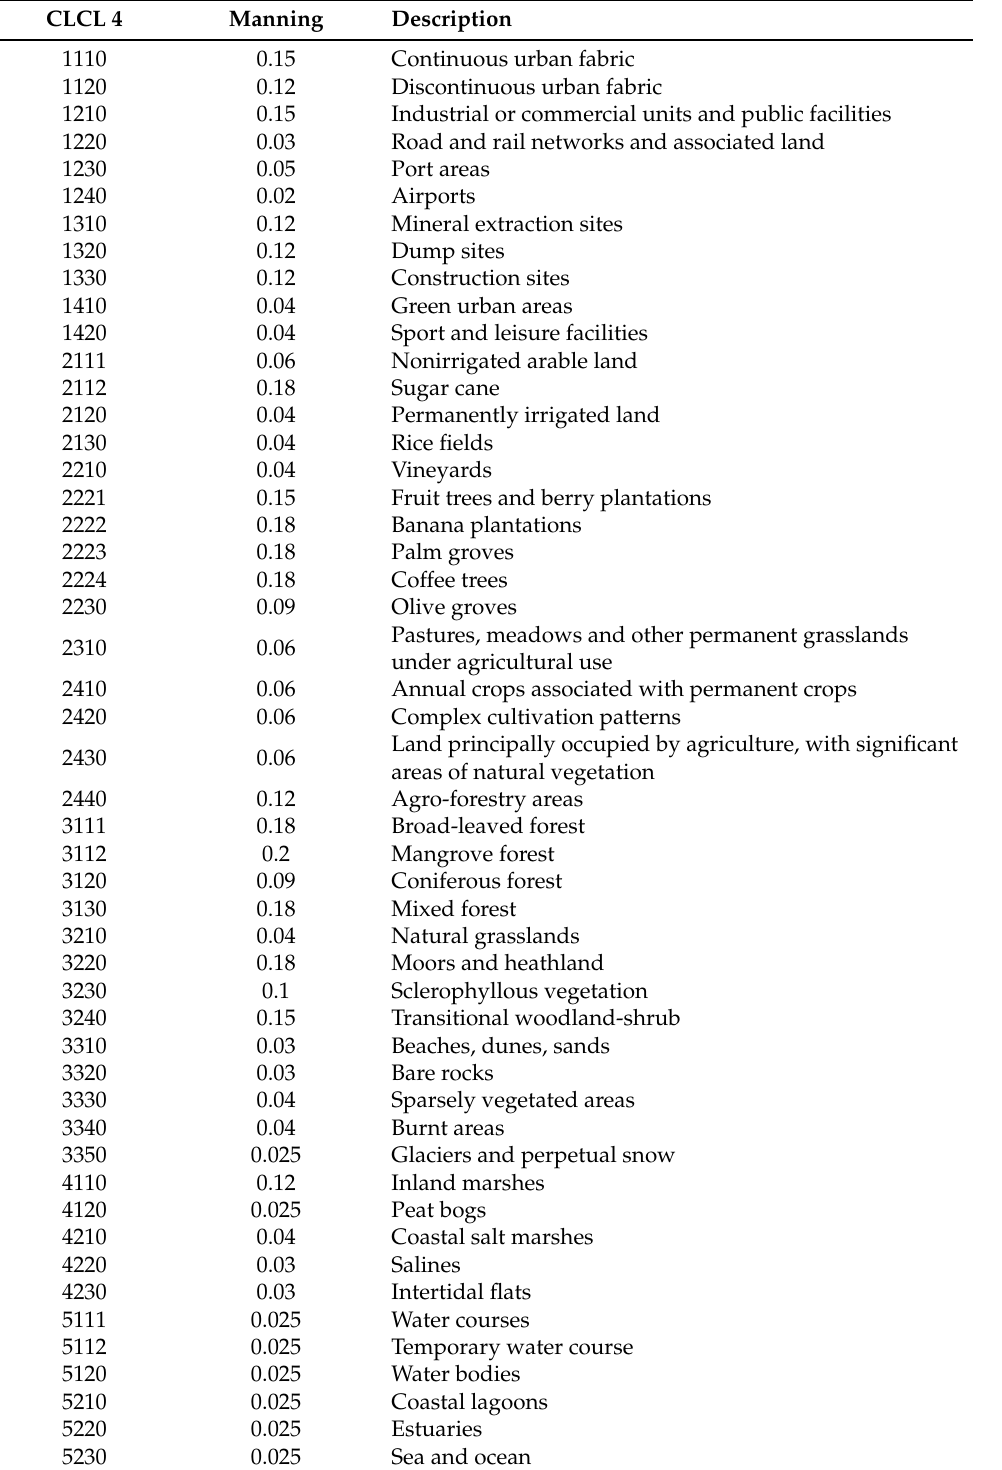
Table 1. Table of Manning coefficients for the aerial coverage according to the Corinne Land Cover